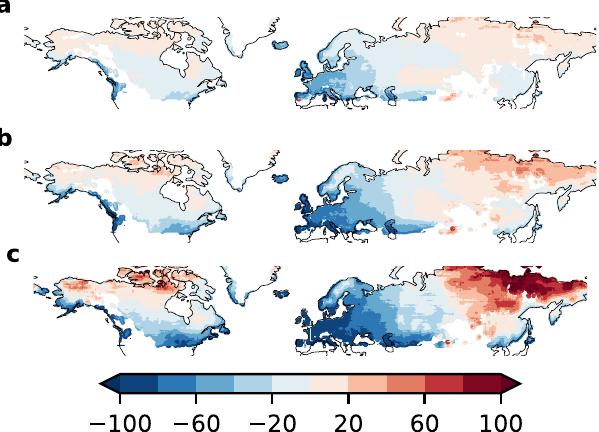
Figure 2. Strong increase in mean daily snowfall in high latitudes of North America and North-East Asia, decreases in mid-latitudes of North America and Western Eurasia relative to historical baseline (1851–1920), (0% points = baseline) ( a ) 2021–2030, ( b ) 2051–2060, ( c ) 2091–2100. Maps created using the cartopy 0.17 24 library based on GSHHG shapes 25